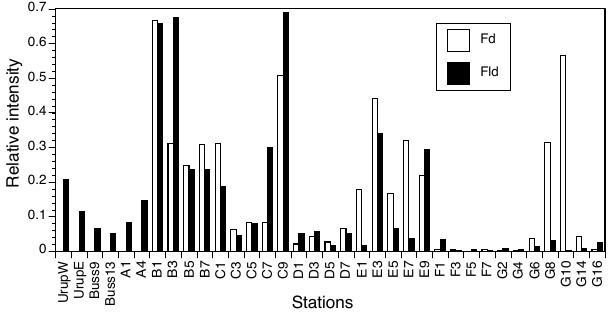
Fig. 5. Relative intensities of ferredoxin (Fd) and flavodoxin (Fld) in micro-sized diatoms in surface waters at each sampling